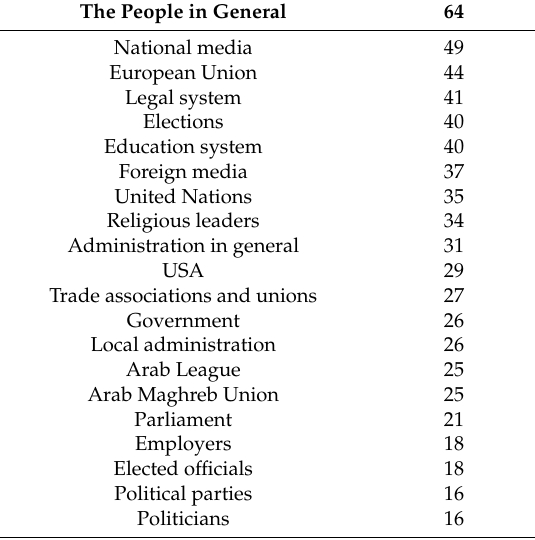
Table 5. Trust scores: percentages scoring 6 or more.